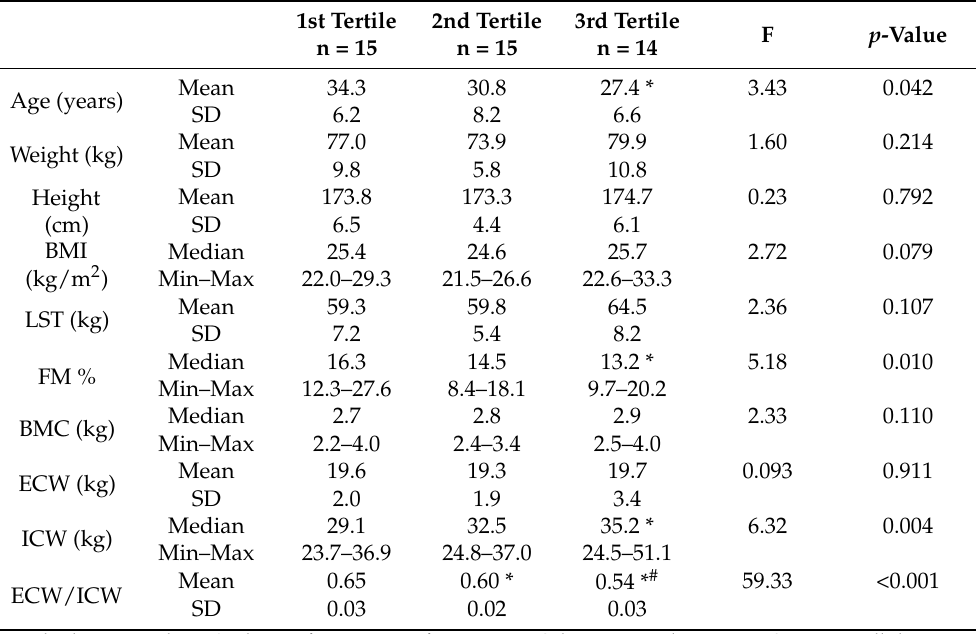
Table 1. General characteristics of the sample, body composition and BIS parameters according to PhA tertiles. 1st Tertile n = 15